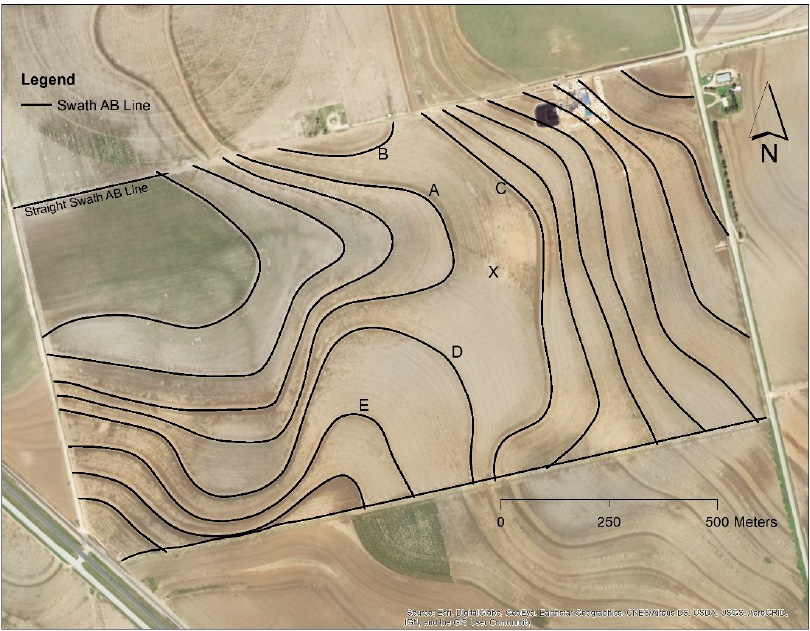
Figure 6. Challenges of using multiple AB lines for guidance in a field with separate parcels of land.